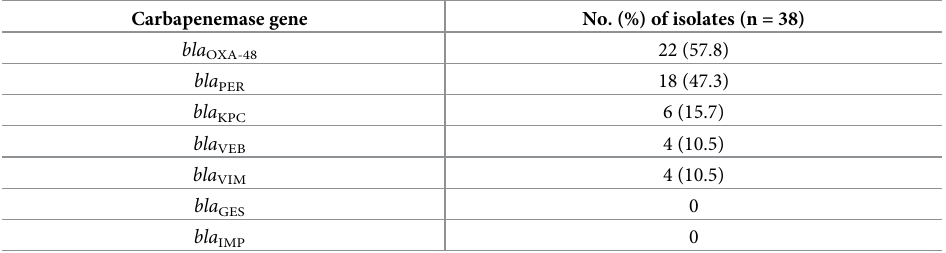
Table 7. Distribution of carbapenemase genes among B2 E . coli isolates from outpatients with acute